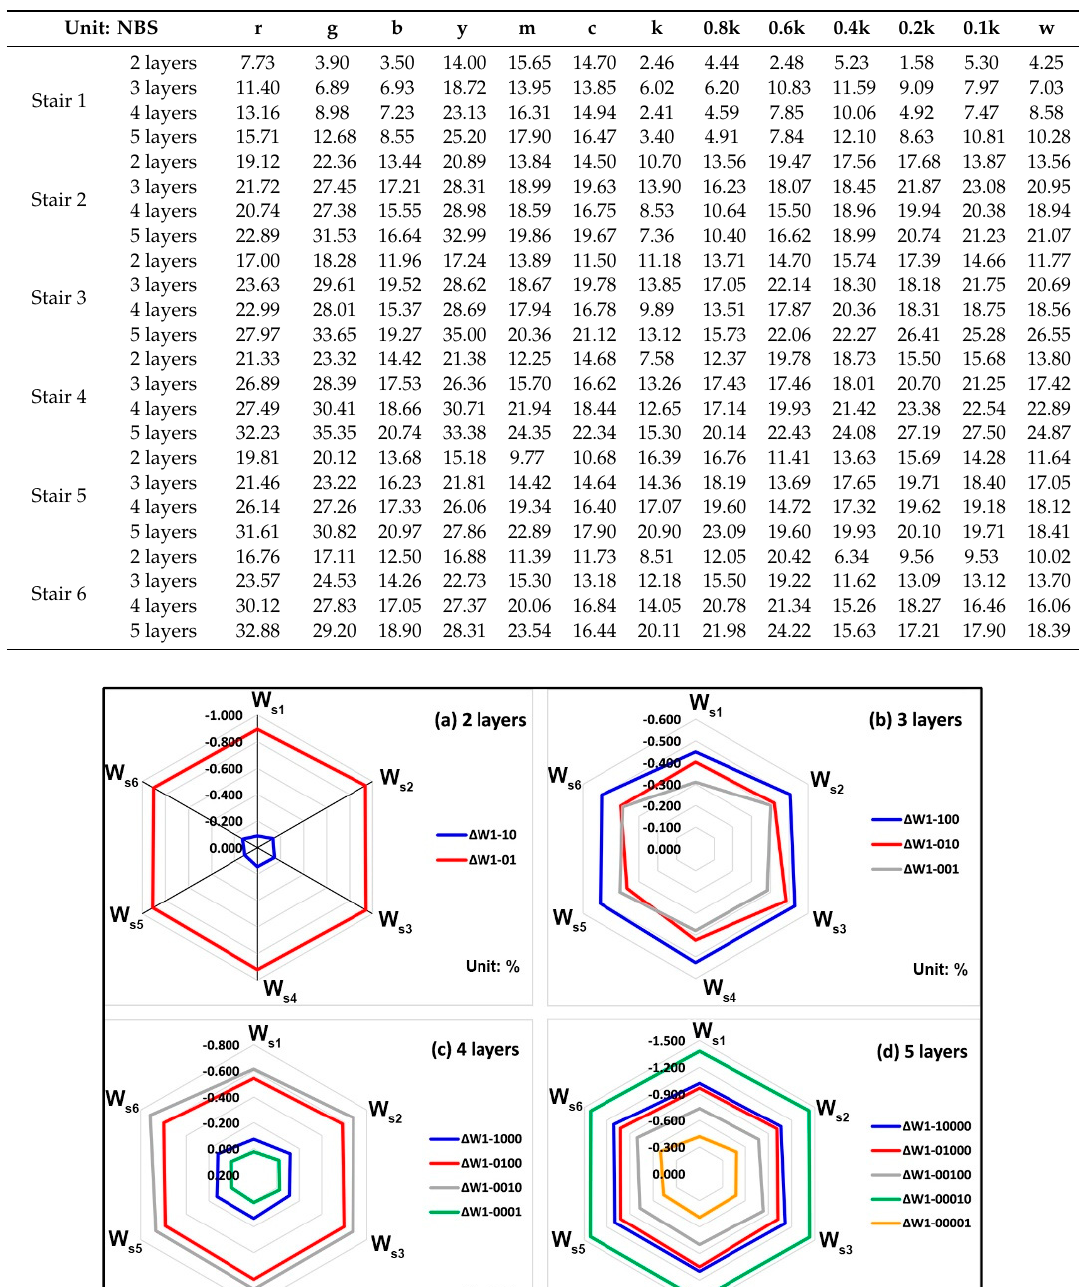
Table 1. The average color di ff erence of all stairs with relative printing layers.